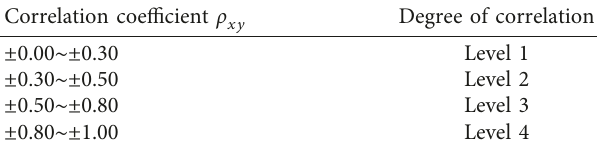
Table 1: Classification of degree of correlation. Correlation coefficient ρ xy Degree of